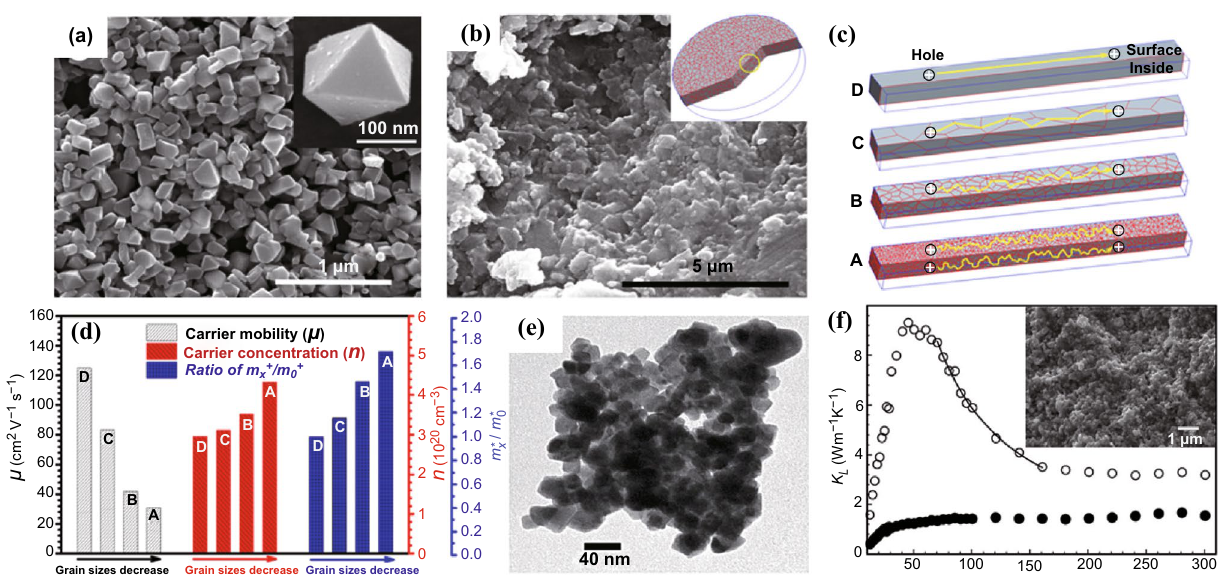
Fig. 5 a SEM image of the SnTe nanoparticles synthesized by microwave hydrothermal method. b SEM image of the dense specimen from the 165 nm nanoparticles. c Proposed electrical transporting mechanism of the dense samples sintered from the 165 nm, 550 nm nanoparticles (NPs), 8.2 μm microparticles (MPs), and mechanically alloyed (MA) powder. d Hole mobility, carrier concentration and the ratio of m x */m 0 * as function of the decreased grain sizes. e TEM image of 40 nm FeSb 2 nanocrystals prepared by solvothermal method. f κ L of the densified FeSb 2 nanocrystals (solid circle) and bulk FeSb 2 (open circle). The line of 1/T dependence (solid line) is indicative of phonon–phonon scattering. The inset shows an SEM image of a fractured surface of the densified FeSb 2 specimen. Adapted with permission from Refs.